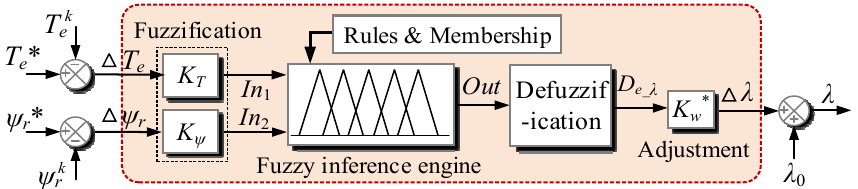
Figure 5. Block diagram of proposed fuzzy adaptive weighting factor tuning method.